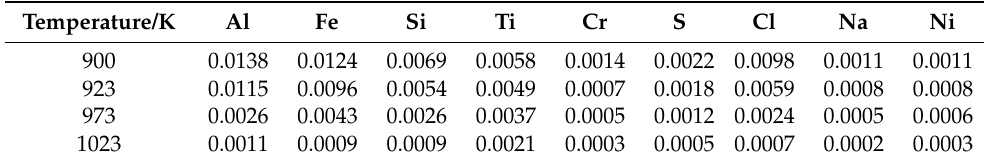
Table 4. Content of the impurities in Mg metal after